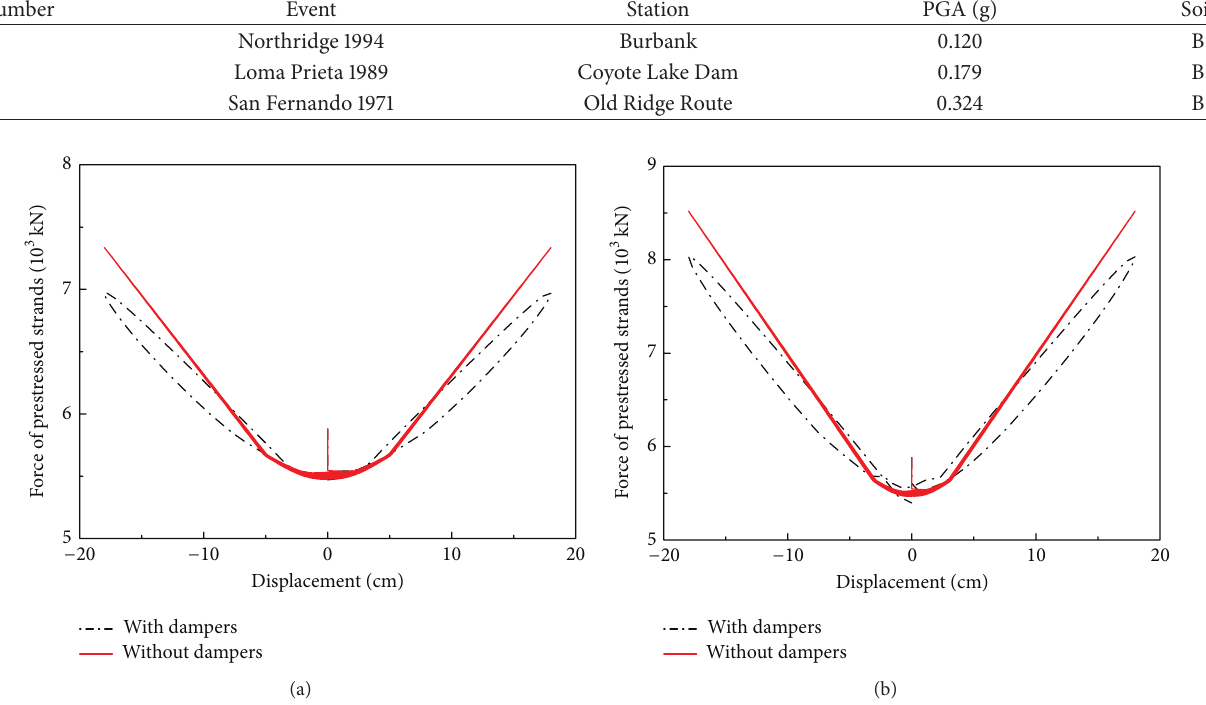
Figure 7: Tension force of the tendons versus lateral top displacement of the pier: (a) longitudinal direction; (b) transverse